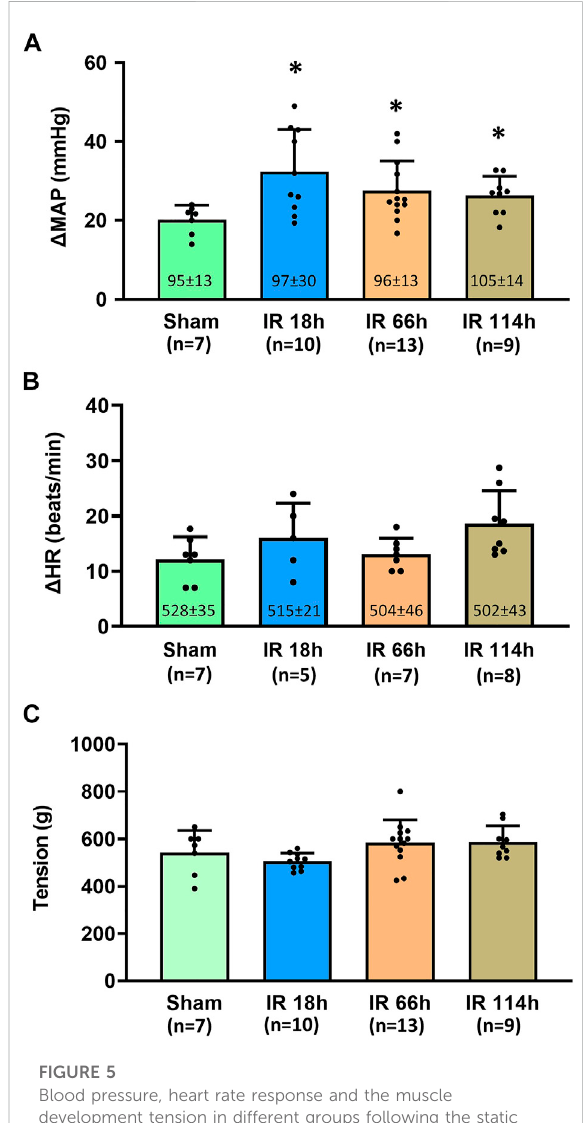
Blood pressure, heart rate response and the muscle development tension in different groups following the static muscle contraction. Experiments were performed in male Sprague-Dawleyrats(200 – 300 g).DatapresentedasMean± SD (A) , Data were analyzed by the non-parametric Kruskal – Wallis test and Mann-Whitney test. Compared with sham rats,